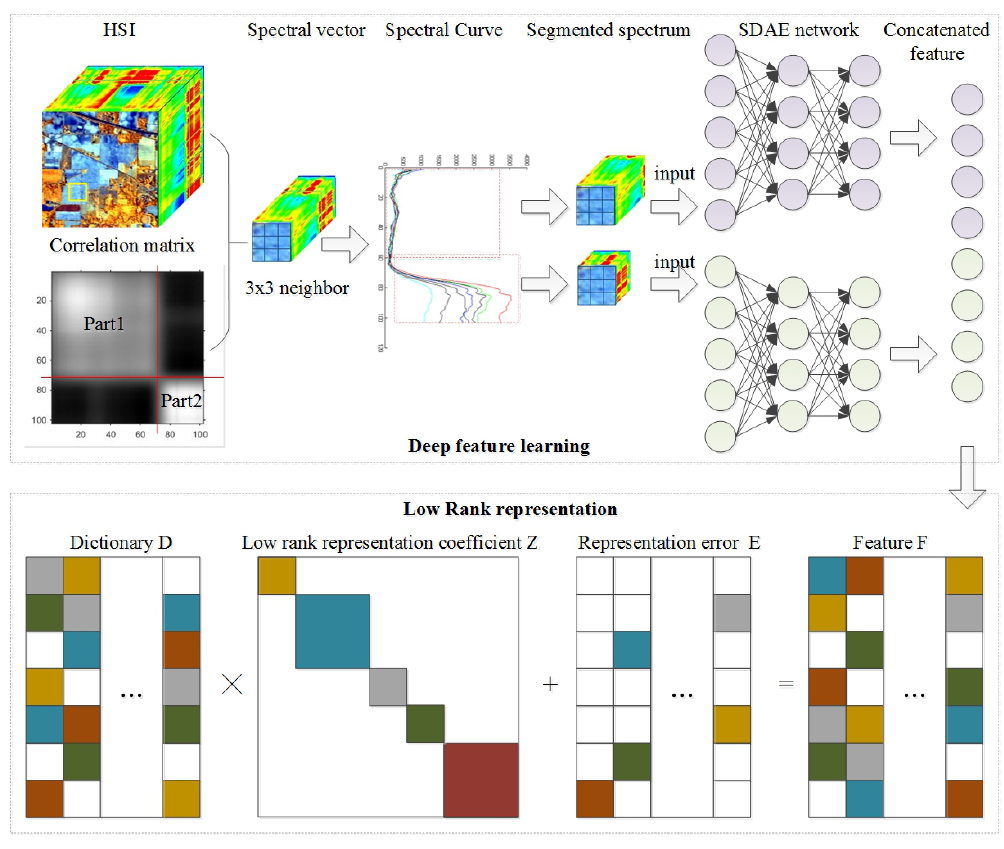
Figure 1. The proposed architecture. HSI: hyperspectral image; SDAE: stacked denoising